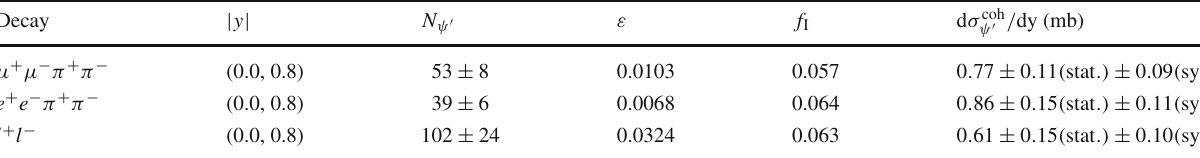
Table 2 Raw ψ (cid:2) yields, ε , f I fractions and coherent ψ (cid:2) cross sections per decay channel